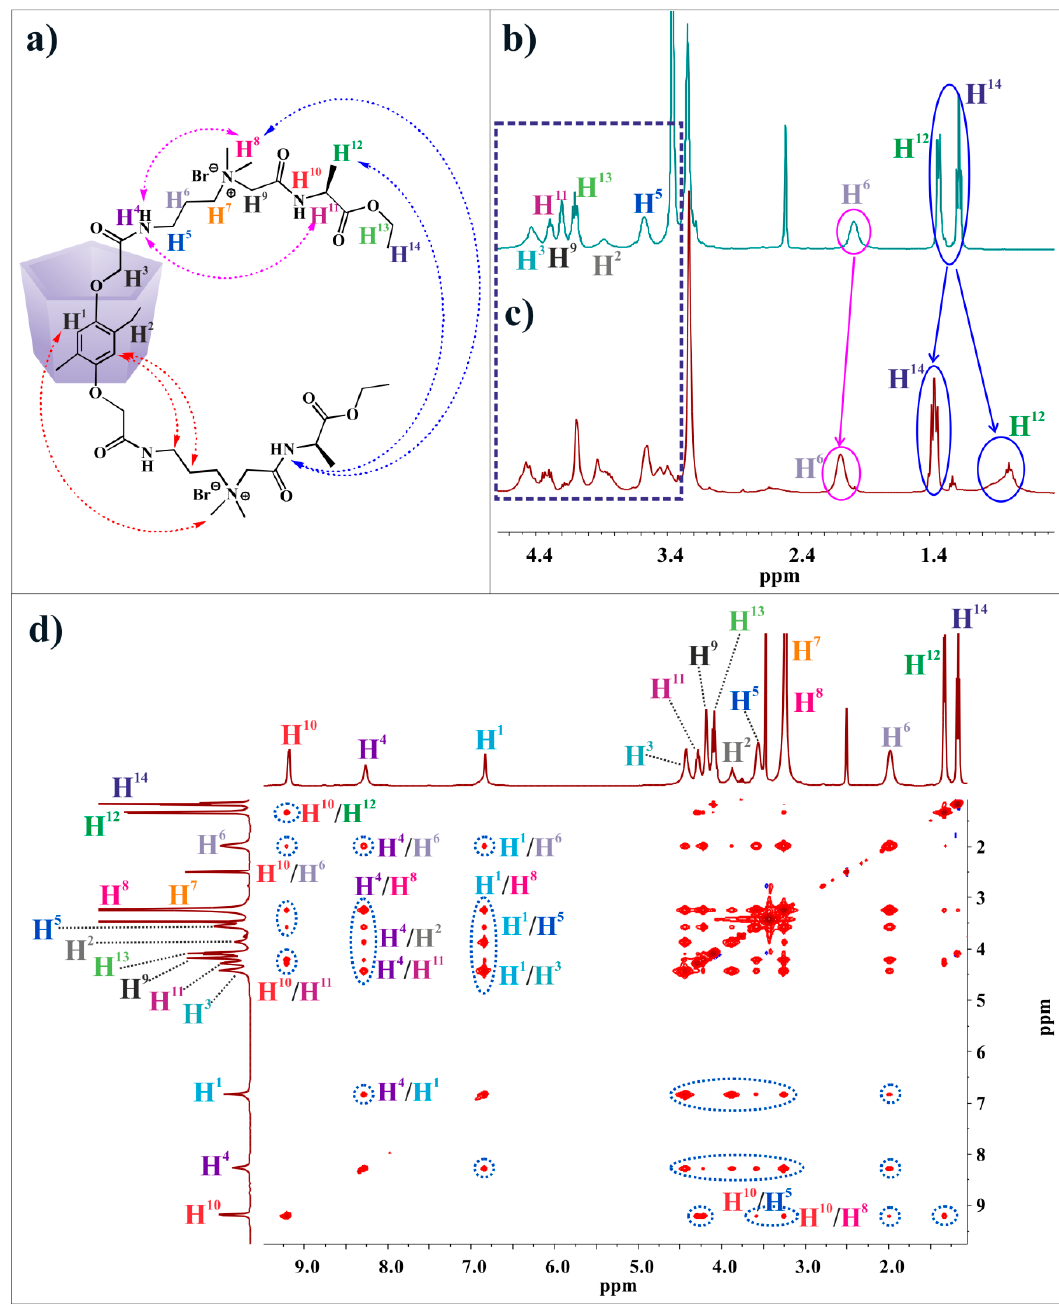
Figure 1. ( a ) Proposed intramolecular interactions for pillar[5]arene 13 ; ( b ) 1 H NMR spectrum of pillar[5]arene 13 at 5 × 10 − 3 M (DMSO-d 6 , 298 K, 400 MHz); ( c ) 1 H NMR spectrum of pillar[5]arene 13 at 5 × 10 − 3 M (D 2 O, 298 K, 400 MHz); ( d ) 1 H- 1 H NOESY NMR spectrum of pillar[5]arene 13 at 5 × 10 − 3 M (DMSO-d 6 , 298 K, 400